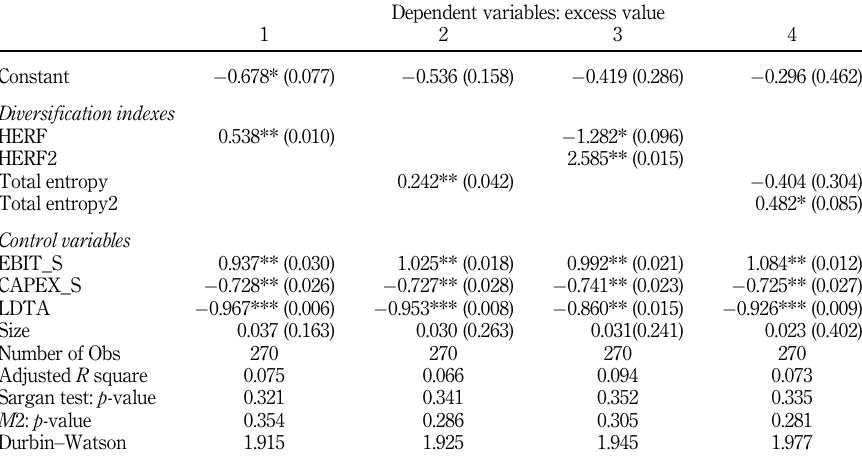
excessvalue[estimated based on Eqns 2 and